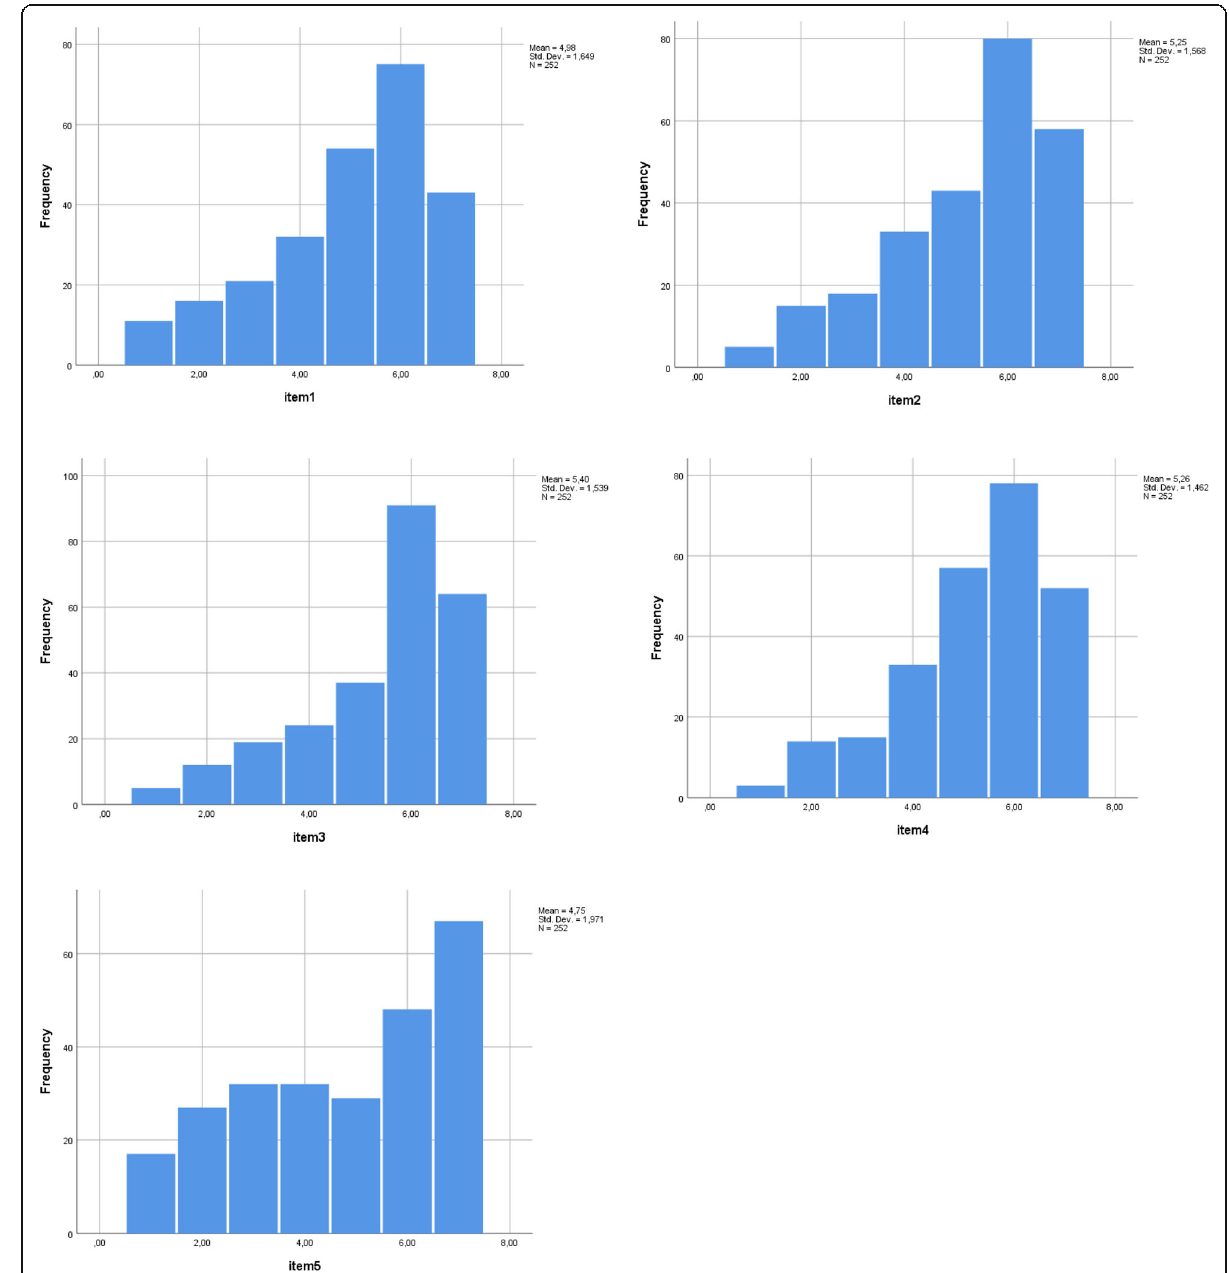
Fig. 1 Participants ’ responses to the items of the Satisfaction with Life